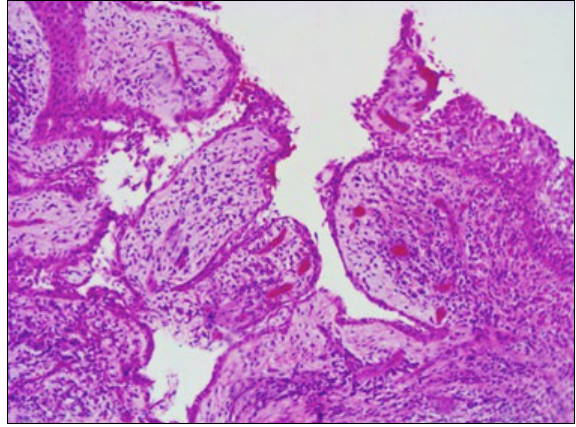
Figure 12. Haematoxylin and eosin (H&E) stained histological sections of the lesion showing a thin non-keratinising stratified squamous epithelial lining surrounded by an inflamed fibrous connective